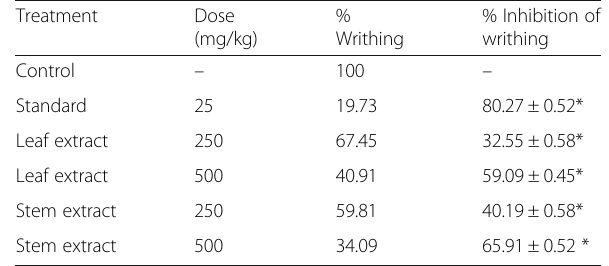
Table 1 Contents of polyphenolic compounds in the ethanol extract of leaf Polyphenolic compound